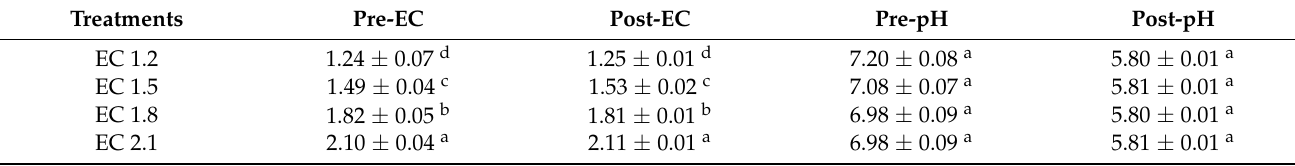
Table 1. Electrical conductivity (EC) and pH of nutrient solutions used in the hydroponic production of arugula taken before (Pre-) and after (Post-) daily adjustment of the nutrient solution. Data represents the mean and standard error of 28 measurements taken